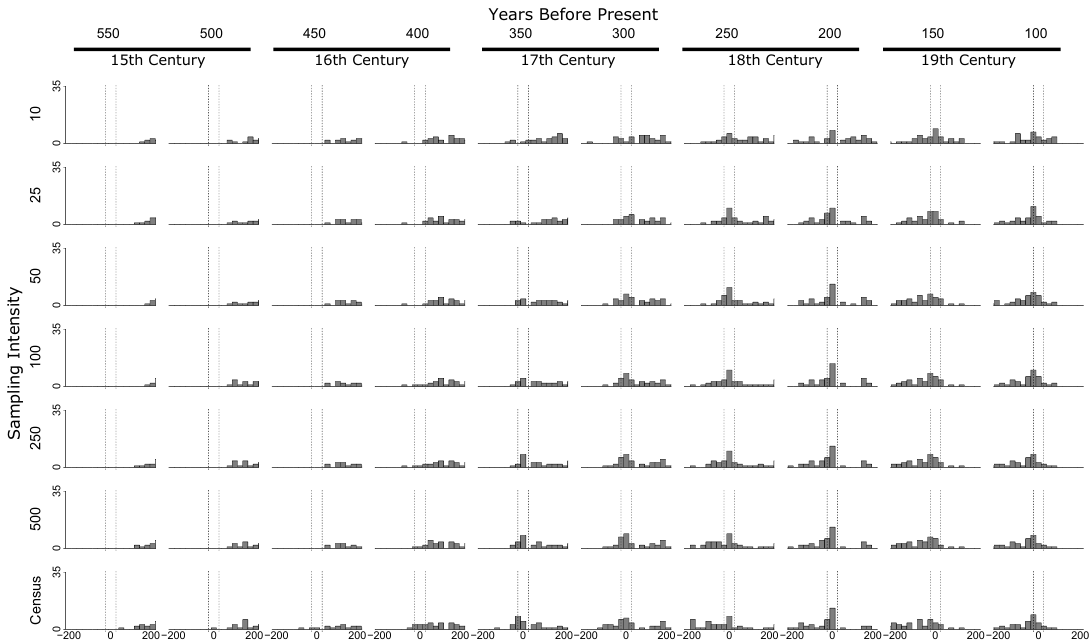
Figure 5. Histograms of inferred regime shifts from moving t -tests relative to the known regime shift date in Scenario 2 (shift from semidecadal patch burning to decadal spreading fires). Columns are for the date before the end of the model run when the forced regime shift happened. Corresponding centuries in the real world are shown for comparison to fire-scar studies. Rows are for di ff erent sampling intensities. Note that in no scenario does the statistical regime shift detection correctly identify the regime shift for the majority of simulations ( > 20 model runs; these histograms are indicated in red in FIGURE 4), even at total census level sampling and for recent regime